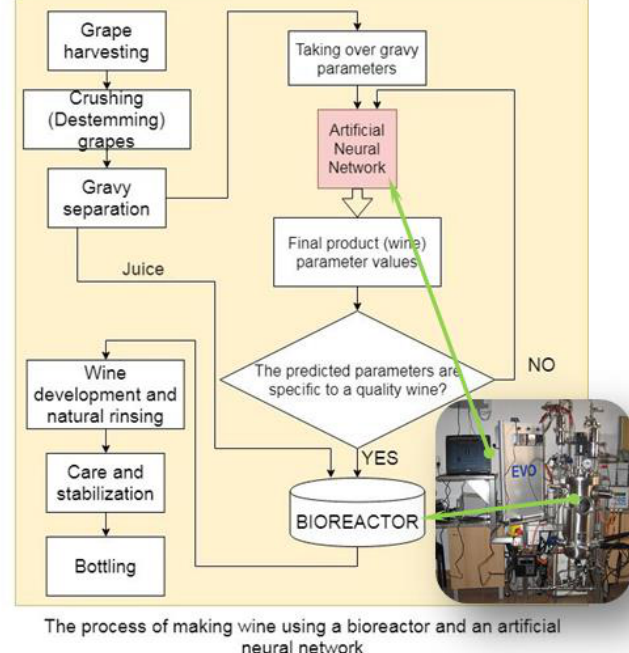
Figure 4. The scheme of using the NN in the technological process of white winemaking.